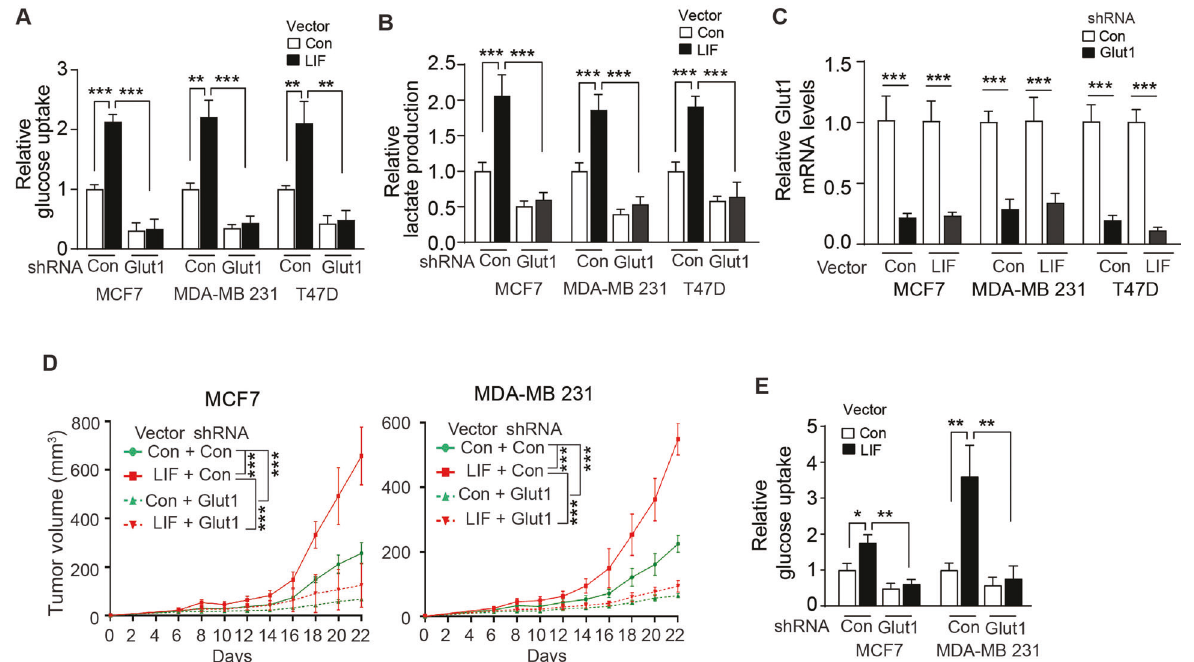
Fig. 5 Knockdown of endogenous Glut1 largely abolishes enhanced glycolysis driven by LIF in breast cancer cells and the promoting effect of LIF on xenograft breast tumor growth. Endogenous Glut1 was knocked down by shRNA in MCF7, MDA-MB 231, and T47D cells with or without ectopic LIF expression. A , B Glucose uptake ( A ) and lactate production ( B ) were measured in cells. C The ef fi ciency of Glut1 knockdown was determined at mRNA levels by qPCR. D Knockdown of Glut1 greatly inhibited the promoting effect of LIF on xenograft tumor growth. MCF7 and MDA-MB 231 cells with or without ectopic LIF expression along with or without Glut1 knockdown were employed for xenograft tumorigenesis assays. E Knockdown of Glut1 greatly blocked the promoting effect of LIF on glucose uptake in xenograft tumors formed by MCF7 and MDA-MB 231 cells. Glucose uptake was measured in xenograft tumors described in D . Data are presented as mean ± SD. In A , B , C & E : n = 3/group; in D : n = 6/group. * p < 0.05; ** p < 0.01; *** p < 0.001; unpaired Student ’ s t -test for A , B , C , E , and 2-way ANOVA followed by Student ’ s t -test for